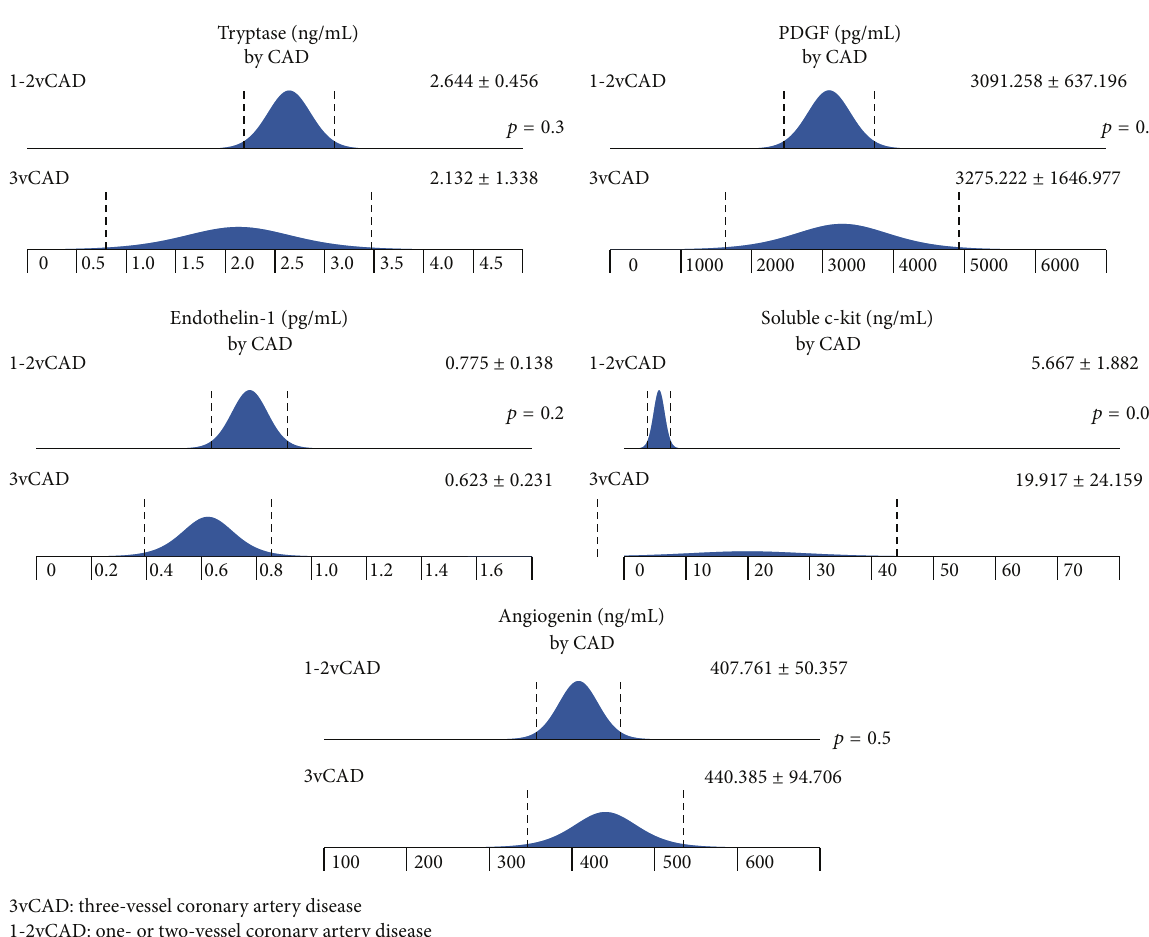
Figure 2: The differences in tryptase, PDGF, soluble c-kit, ET-1, and angiogenin levels among patients with 1-, 2-, and 3-vessel CAD. The analysis was made using 𝑡